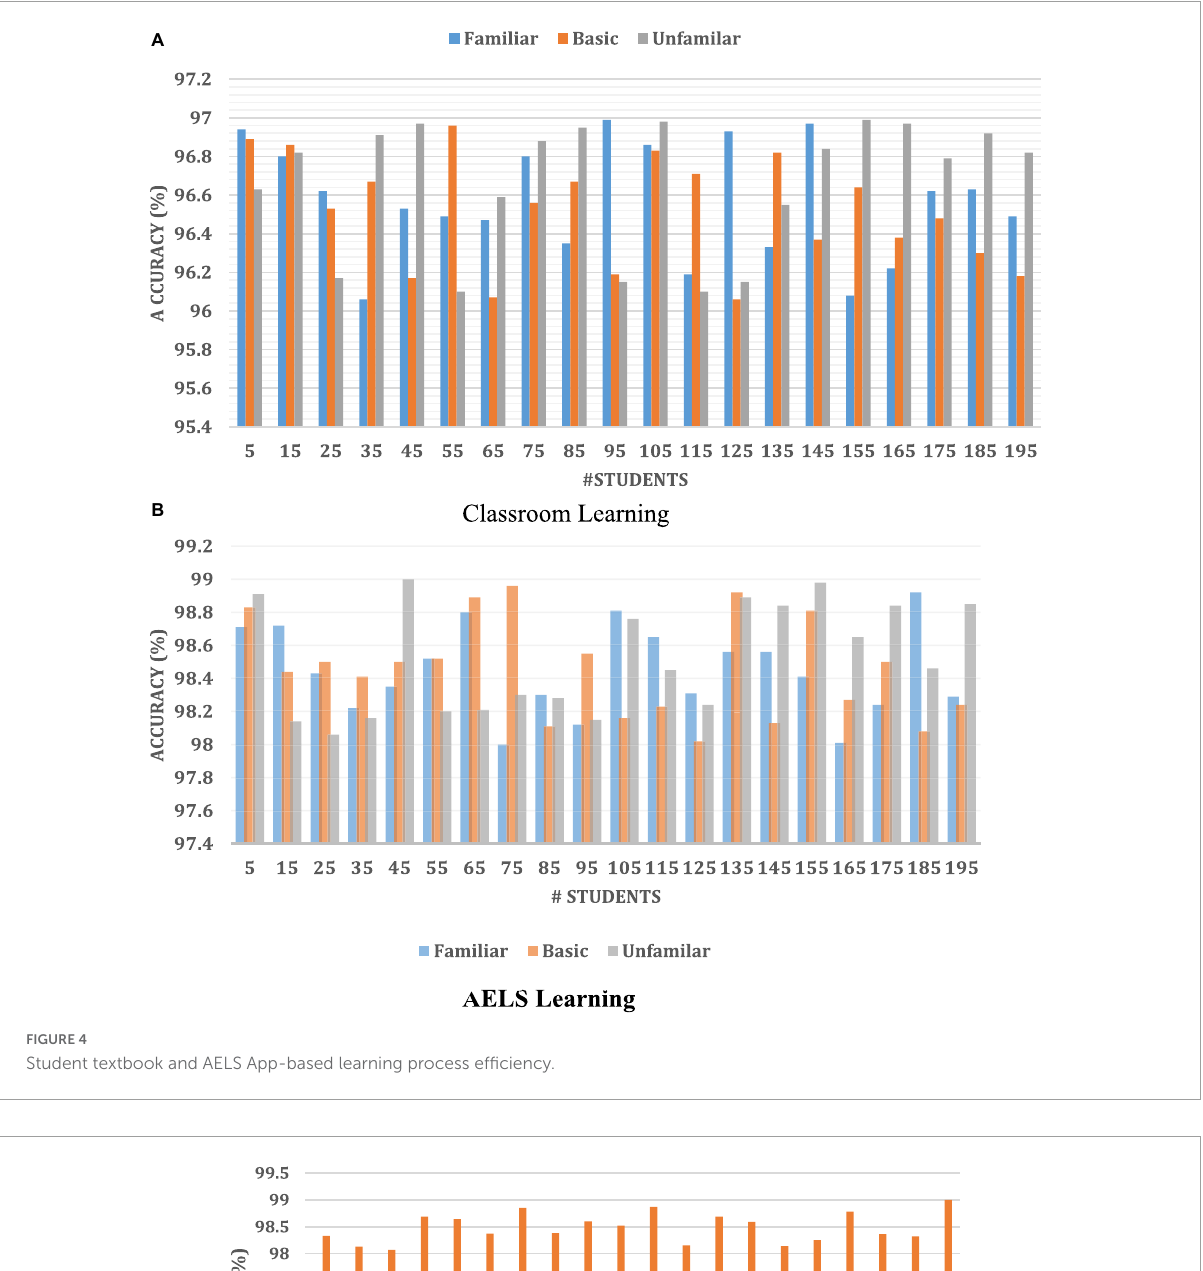
FIGURE4 Student textbook and AELS App-based learning process efficiency.